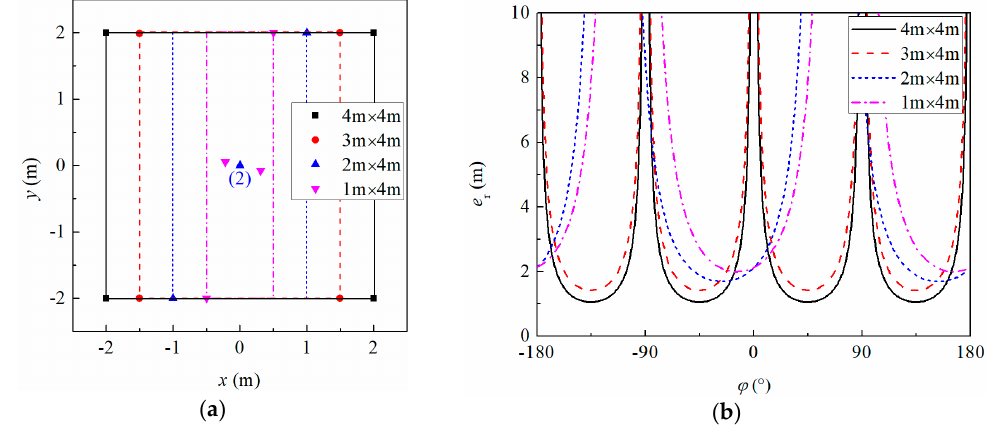
Figure 6. Optimization results of rectangular constraint area with different aspect ratios: ( a ) array deployment; ( b ) Cramér-Rao lower bound (CRLB) curve.